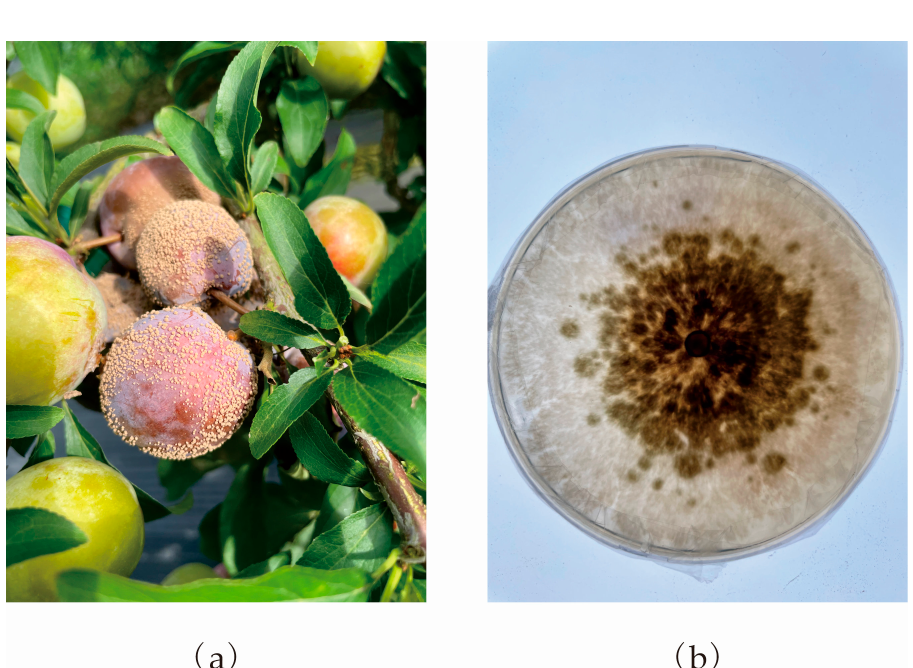
Figure 8. The representative figure of the plum fruit with BR ( a ) and cultured M. fructicola ( b